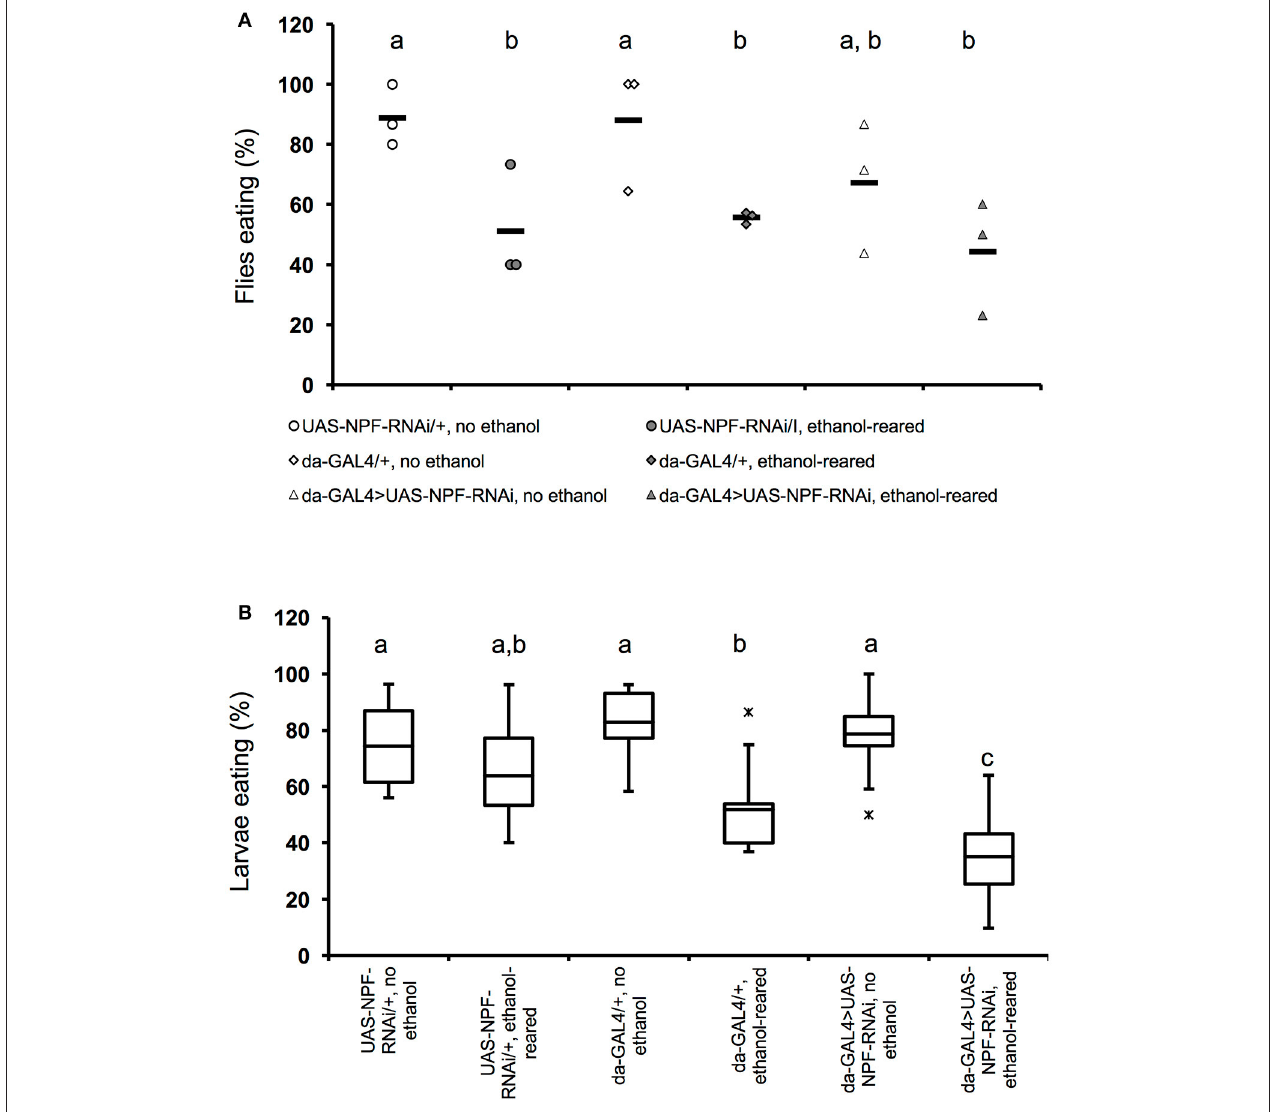
FIGURE 2 | Flies with partial loss of npf signaling show reduced feeding when ethanol-supplemented. (A) Percentage of adult female flies that ate within a 4-min interval after 6h of food deprivation. ( N = 3 for all conditions and genotypes, P = 0.0022 for the effect of ethanol-rearing, NS for the effect of loss of npf ( P = 0.24, two-way ANOVA with Tukey’s post-hoc analysis). Solid bars indicate means; individual data points are represented as open or closed circles. (B) Percentage of early third instar larvae that ate within a 20-min interval after 2h of food deprivation ( N = 11, 11, 8 6, 10, 8. P < 0.0001 for the effect of ethanol-rearing, P = 0.11 for the effect of loss of npf , P = 0.0053 for the interaction between genotype and condition, two-way ANOVA with Tukey’s post-hoc analysis). Center lines show the sample mean; box limits indicate the 25th and 75th percentiles as determined by R software; whiskers extend 1.5 times the interquartile range from the 25th and 75th percentiles; outliers are represented by “x.” Boxes sharing the same letter do not differ significantly, while boxes with different letters are significantly different ( P < 0.05).